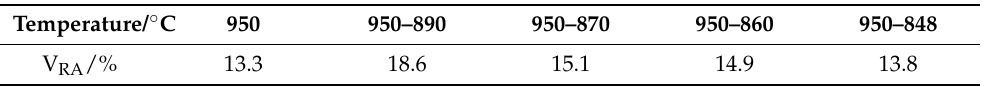
Table 2. The volume fraction of the retained austenite of the samples after high-temperature two-step isothermal